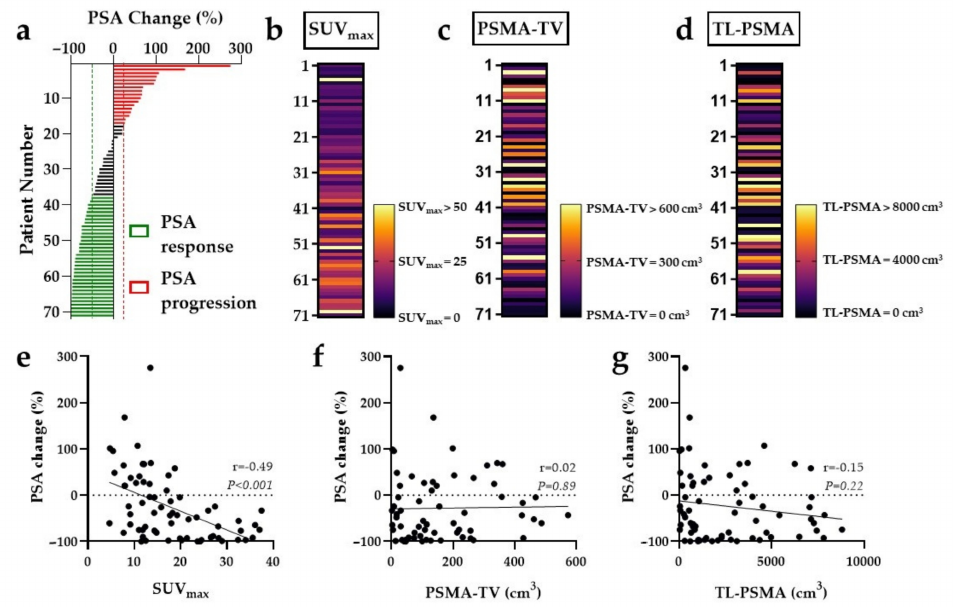
Figure 1. Change of prostate-specific antigen (PSA) values relative to maximum standardized uptake value (SUV max ), prostate-specific membrane antigen-based tumor volume (PSMA-TV) and total lesion (TL)-PSMA. ( a ) Waterfall plot of PSA change after two cycles of 177 Lu-PSMA-617 radioligand therapy presented in order of increasing PSA response. Interindividual heterogeneity in SUV max levels ( b ), PSMA-TV ( c ), and TL-PSMA ( d ) derived from baseline 68